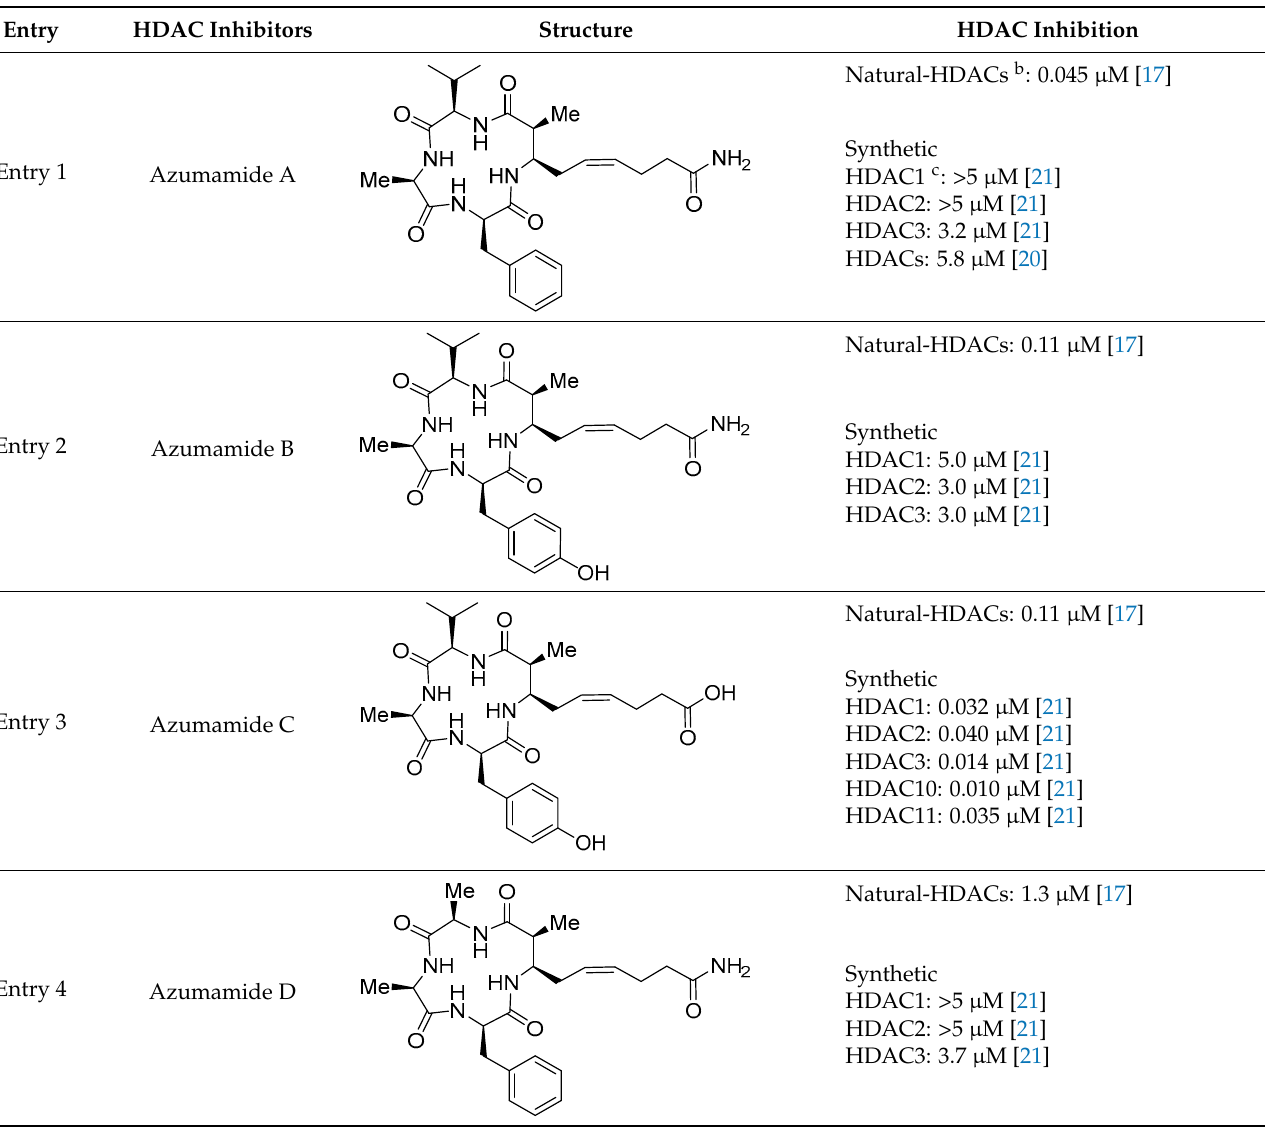
Table 1. HDAC inhibitory activities of azumamides and their analogs a .